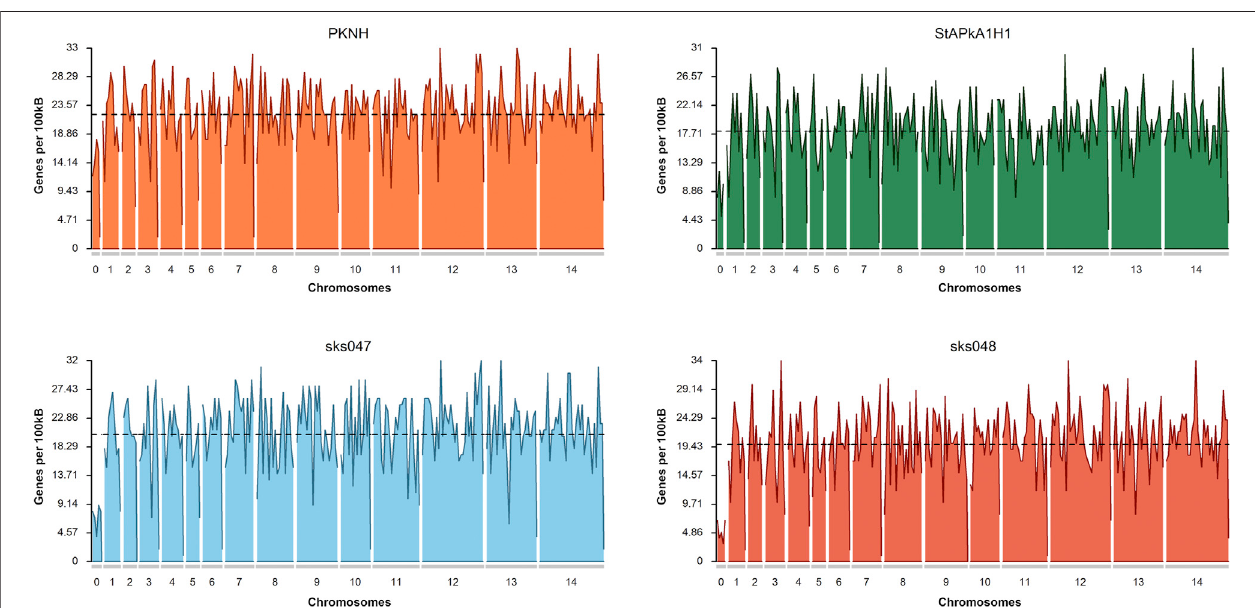
FIGURE2 | Gene density plots for the P. knowlesi PKNH referencegenome, StPkA1H1, sks047, and sks048 draft genomes.Gene density iscalculated based on the number of identi fi ed genes within a sliding window of 100 kb. Mean density shows the PKNH reference genome to have 22.05 genes per 100 kb, StAPkA1H1 to have 18.15, sks047 to have 20.25, and sks048 to have 19.8. Plots were generated using karyoploteR (Gel and Serra,